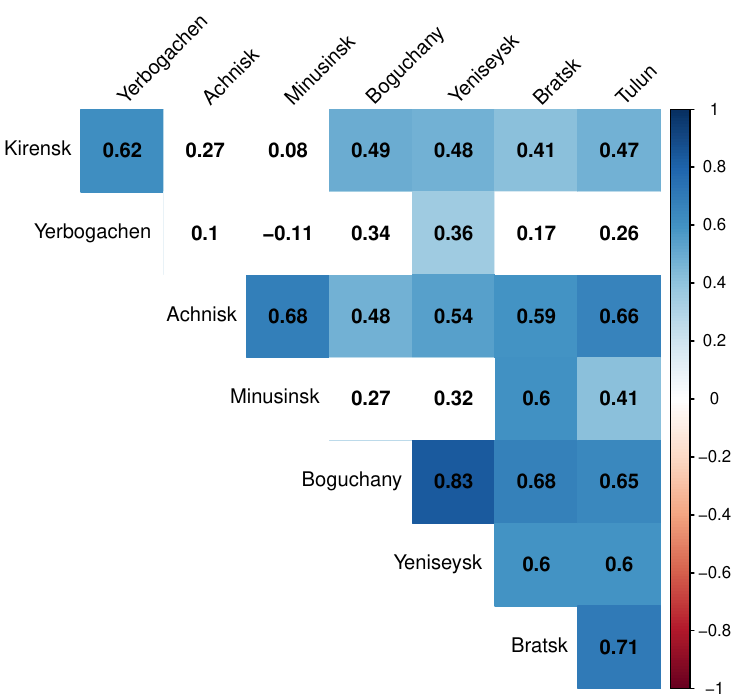
Figure 4. Pearson correlations between expectable durations of logging seasons by meteorological stations of Krasnoyarsk Krai and Irkutsk Oblast: